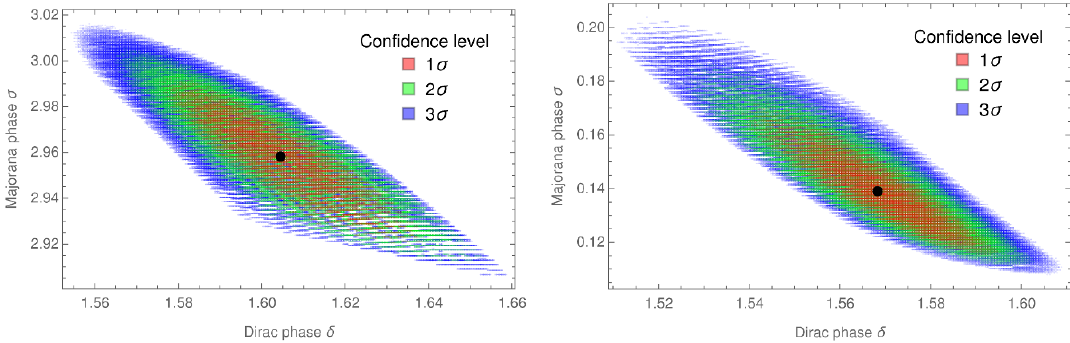
Figure 6 . Stability of the predictions for ( (cid:14); (cid:27) ) under variation of the experimental input parameters (cid:14)m 2 , (cid:1) m 2 , sin 2 (cid:18) 12 , sin 2 (cid:18) 13 , and sin 2 (cid:18) 23 for an exact B 1 ; 4 texture (left panel) and an exact B 2 ; 5 texture (right panel) . The black dots mark the predictions for ( (cid:14); (cid:27) ) if all observables are set to their best-(cid:12)t values, ( (cid:14); (cid:27) ) = (0 : 51 ; 0 : 94) (cid:25) in the B 1 ; 4 case and ( (cid:14); (cid:27) ) = (0 : 50 ; 0 : 04) (cid:25) in the B 2 ; 5 case, see eq. (2.18). (cid:31) 2 is calculated according to eq. (5.1).